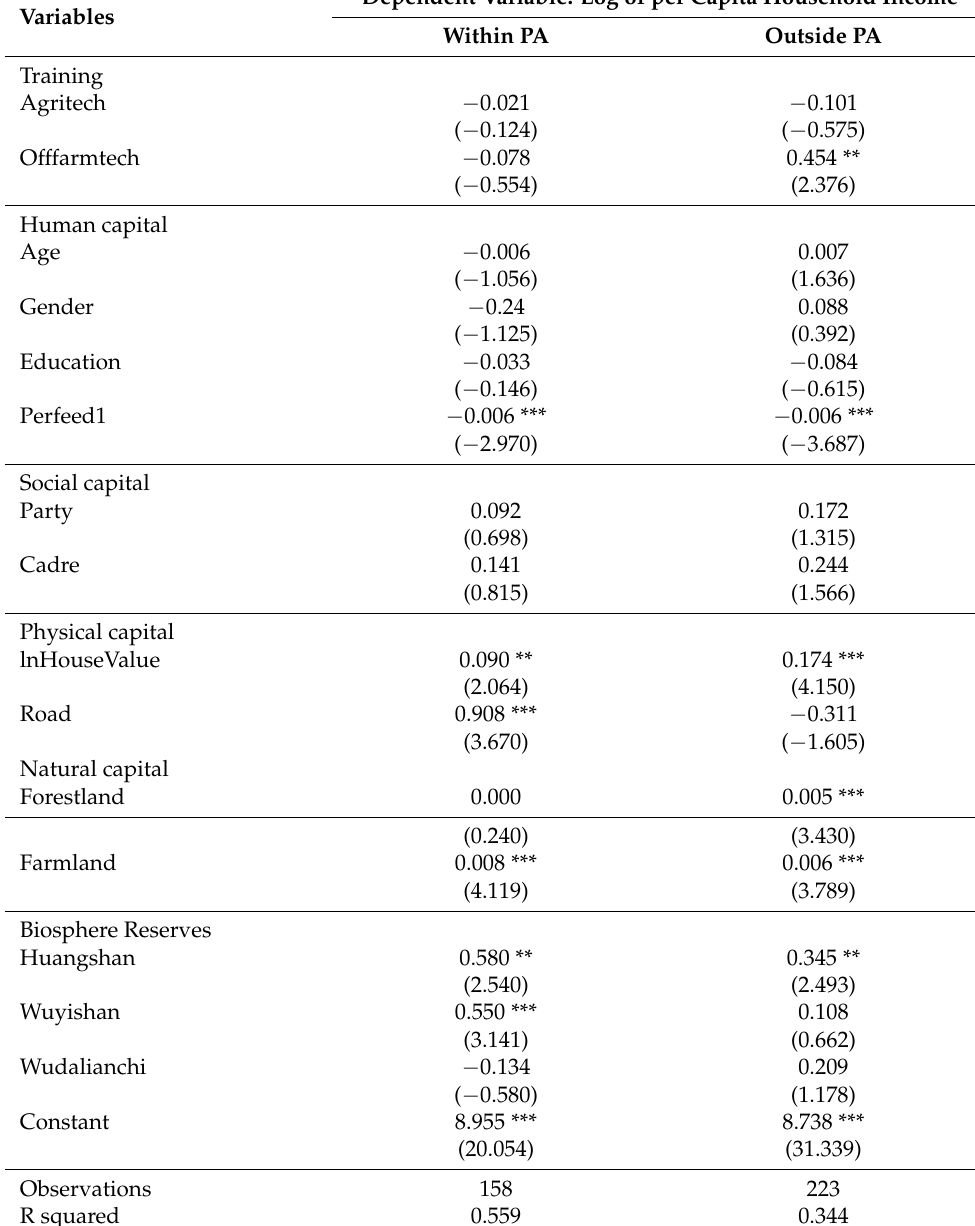
Table 4. The impact of skill training on per capita household income within and outside PAs.